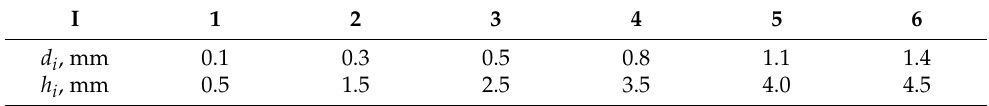
Table 1. The dimensions of the RS